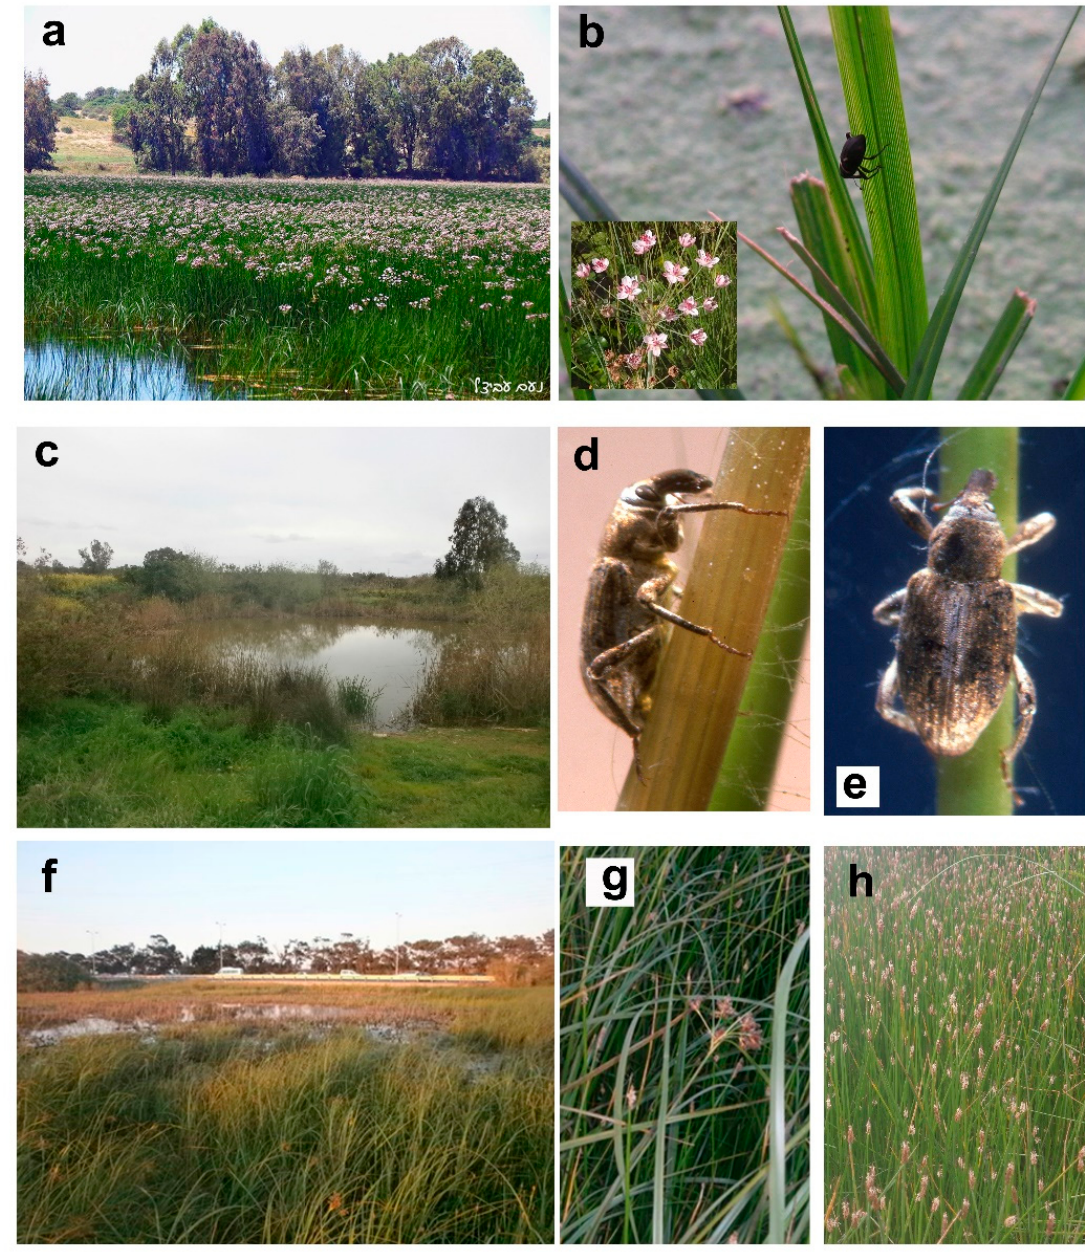
Figure 4. ( a ) Berekhat Ya’ar, Central Coastal Plain, Butomus umbellatus blooming (courtesy Noam Avitzel); ( b ) same place, Bagous validus feeding on Butomus umbellatus (courtesy David Furth), on smaller photograph flowers of B . umbellatus ; ( c ) ‘En Nimfit Nature Reserve, Migdalit haNehalim Pond, vernal pond; ( d ) Picia syriaca , lateral view, photographs taken in lab, Tel Aviv University (courtesy Amikam Shoob); ( e ) same, dorsal view (courtesy Amikam Shoob); ( f ) Ga’ash Winter Pool Nature Reserve, vernal pool, Eleocharis palustris and Scirpus maritimus ; ( g ) same place, Scirpus maritimus ; ( h ) Nizzanim Dunes Nature Reserve Roberts’ Pool, vernal pool, Eleocharis palustris . Vernal (seasonal, ephemeral) pools, featuring water only during the winter and early spring, occur in Israel along the coastal plain, on the western slopes of the Samarian and Judean Hills, in the uplands of the Upper and Lower Galilee, and on the Golan Heights. In the coastal area they have mainly replaced the historical swamps. Some of the vernal pools may contain water throughout